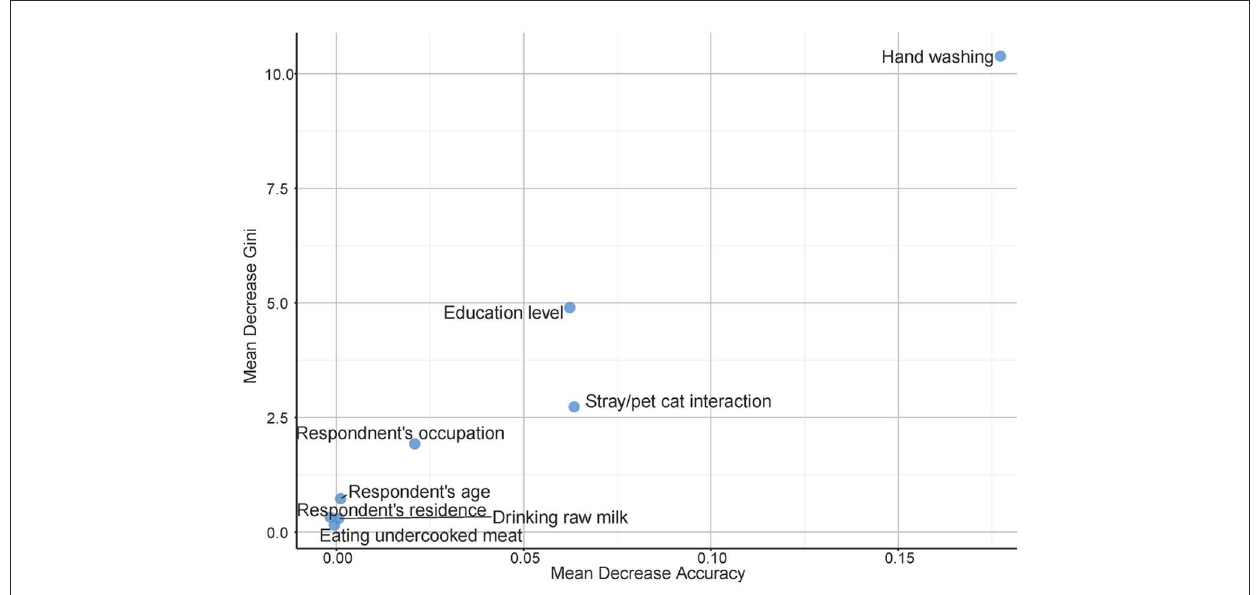
FIGURE1 Multi-way variable importance plot from the best random forest model for risk factors associated with toxoplasmosis among pregnant women in Sharqia Governorate, Egypt.